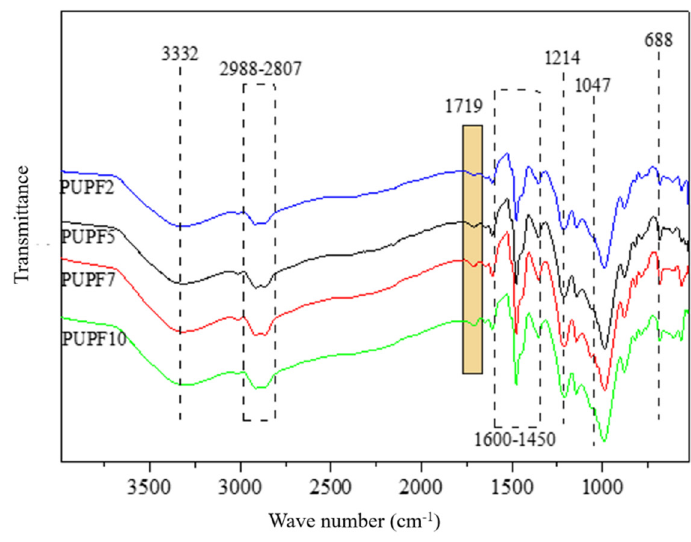
Figure 4. FTIR spectra of PU/poplar wood flour hybrid enhanced PF.